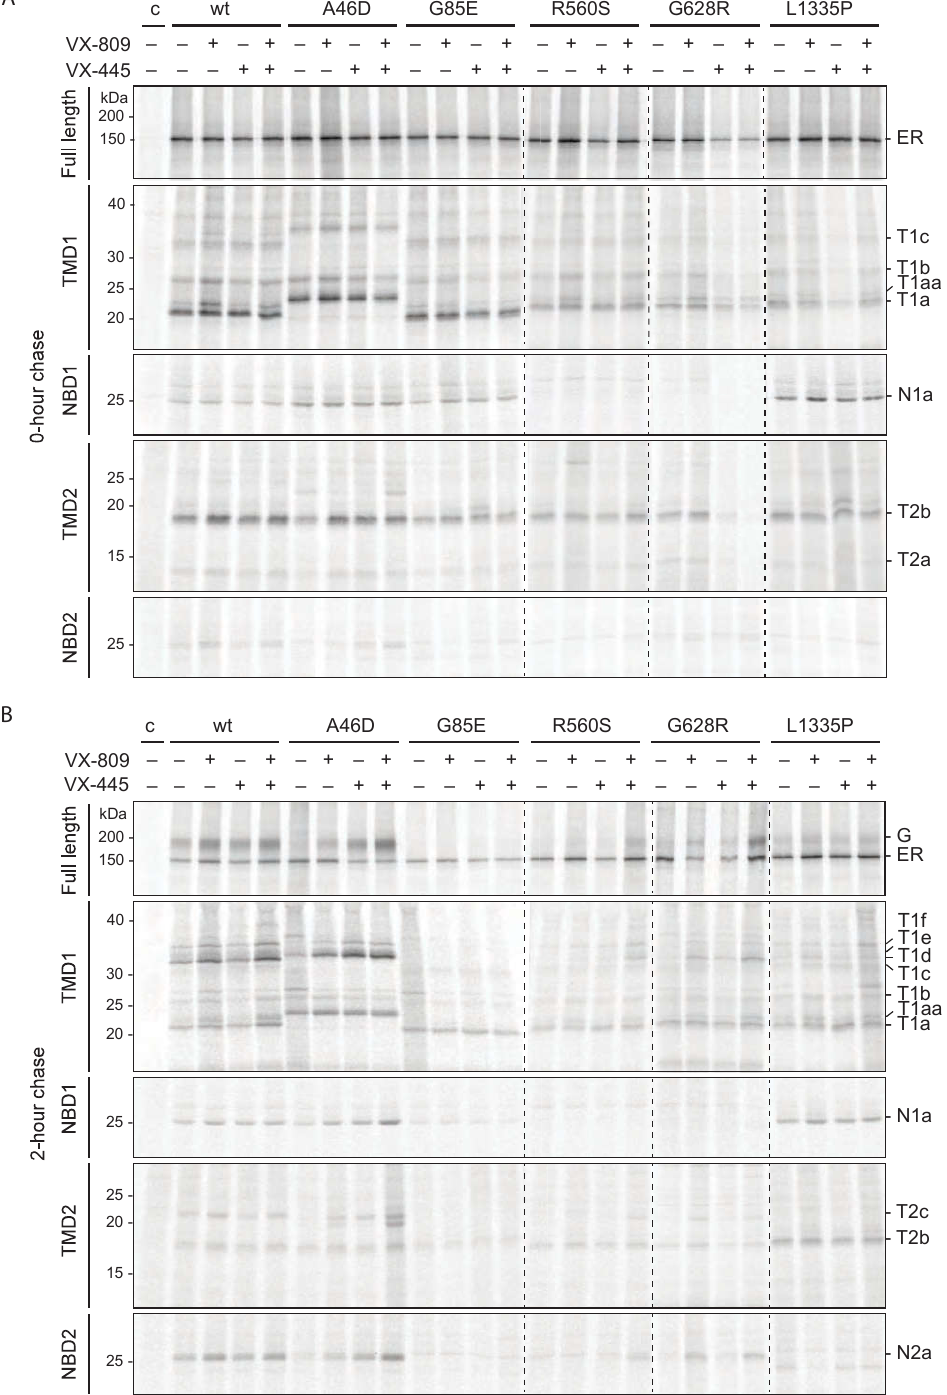
Figure 9. Some hypo-responders are rescued by combination treatment with VX-445 ( A ) HEK293T cells expressing wild-type and mutant CFTR were radiolabeled for 15 min. VX-809 (3 µ M) was added during starvation, pulse, and chase. VX-445 was added during the starvation (3 µ M), pulse (3 µ M), chase (3 µ M), stop on ice (30 µ M), and lysis on ice (30 µ M). CFTR was analyzed as in Figure 4. The top panel shows undigested CFTR and the lower panels show domain-specific fragments immunoprecipitated after digestion with 25 µ g/mL proteinase K. ( B ) As in ( A ), but radiolabeled proteins in the cells were chased for 2 h. Quantifications are in Figure